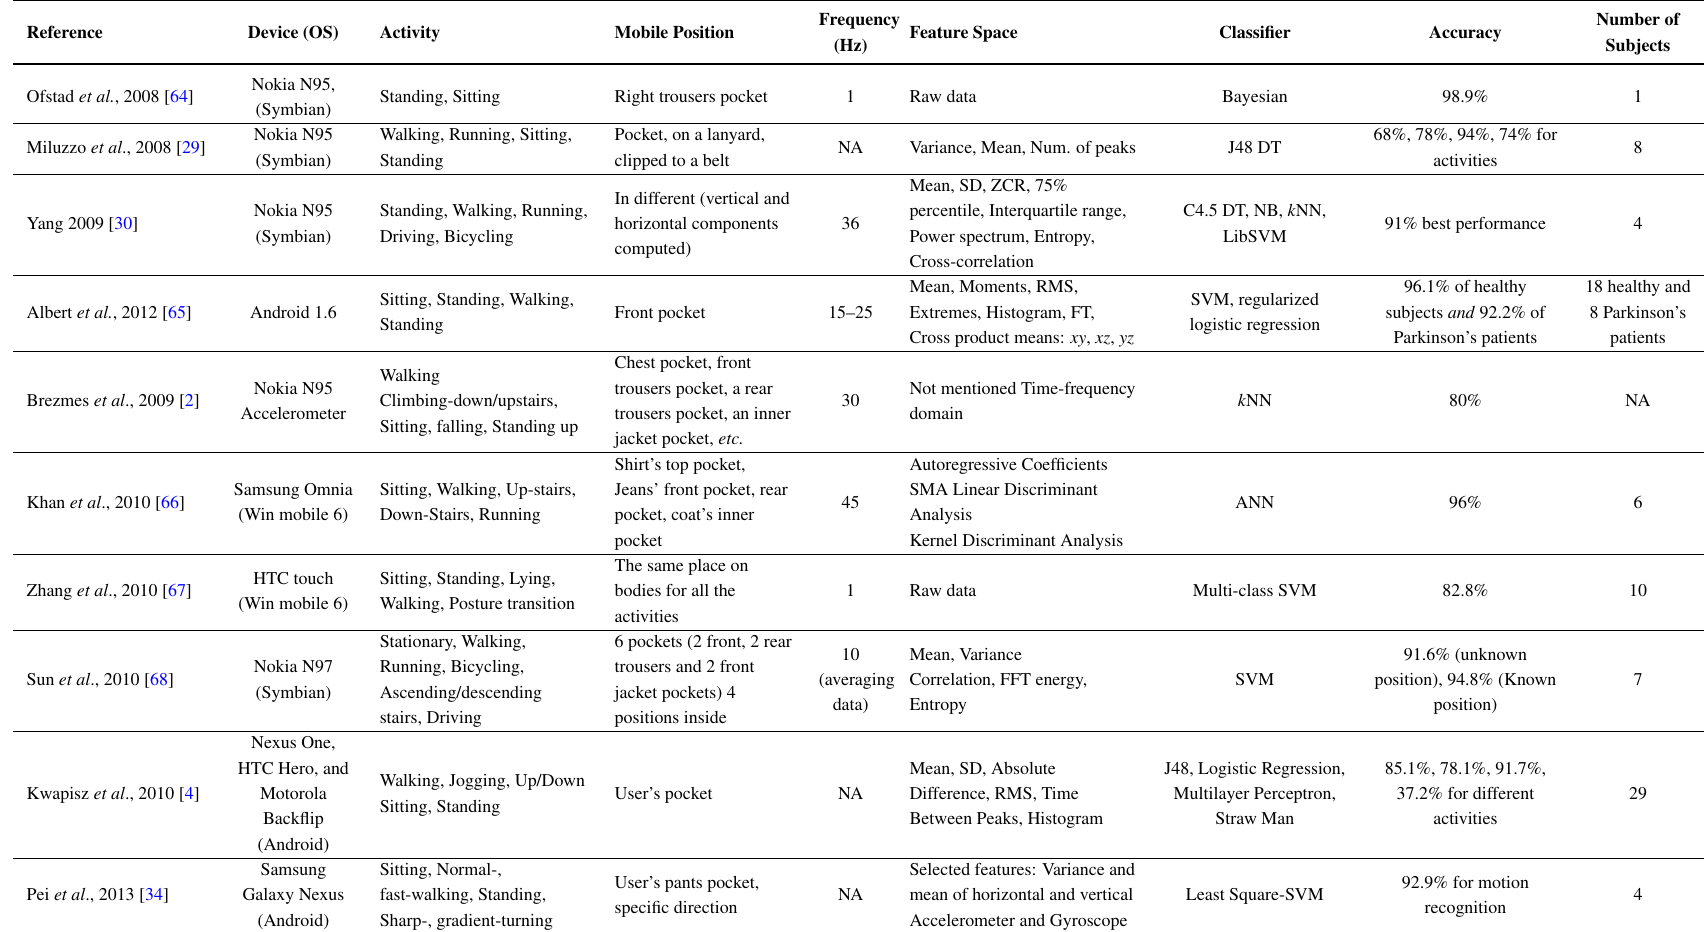
Table 3. Summary of past work on activity recognition using